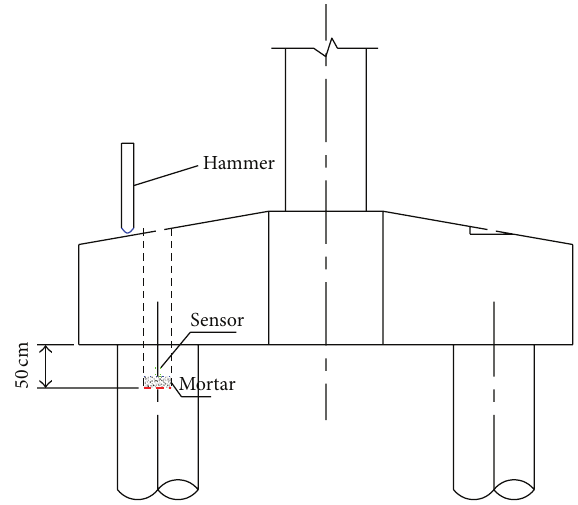
Figure 4: Sensor installed on top of the pile during the PEM test.